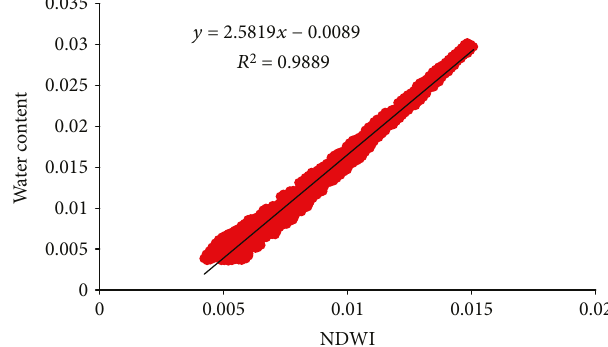
Figure 10: The statistical model of water content and the